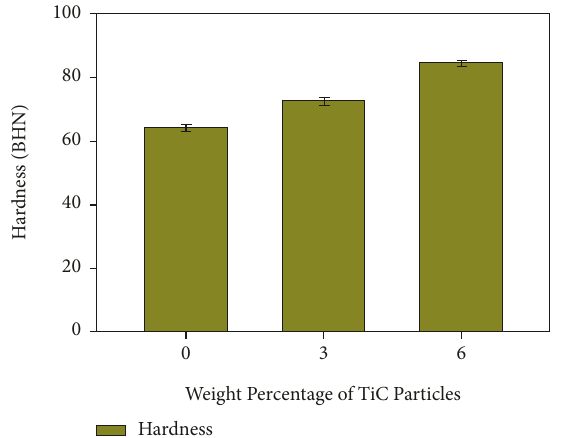
Figure 7: Hardness of Al7075 alloy with TiC composites.